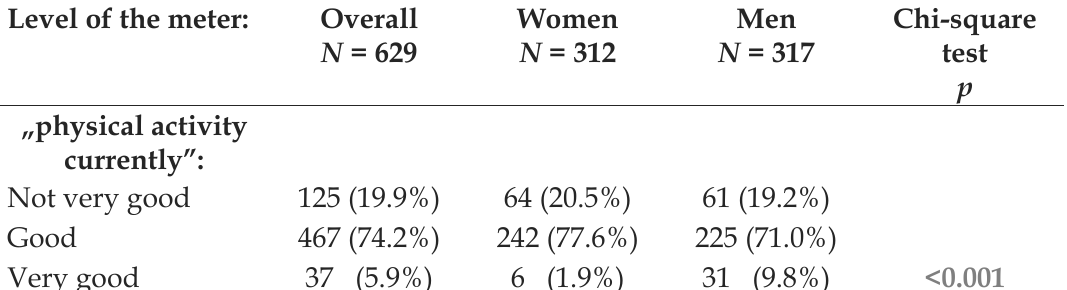
Basic statistics (numbers and proportions) of students differing in the level of SPM “physical activity currently” due to